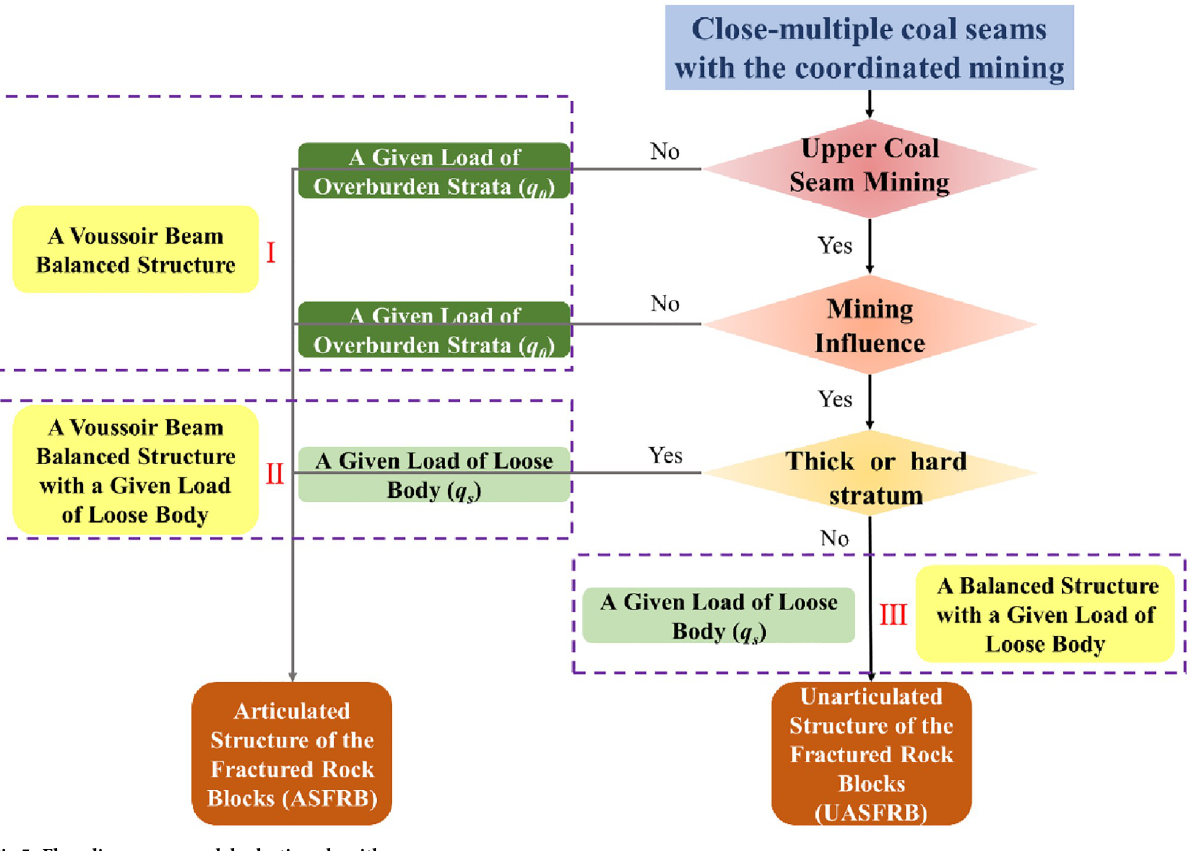
Fig 5. Flow diagram or model selection